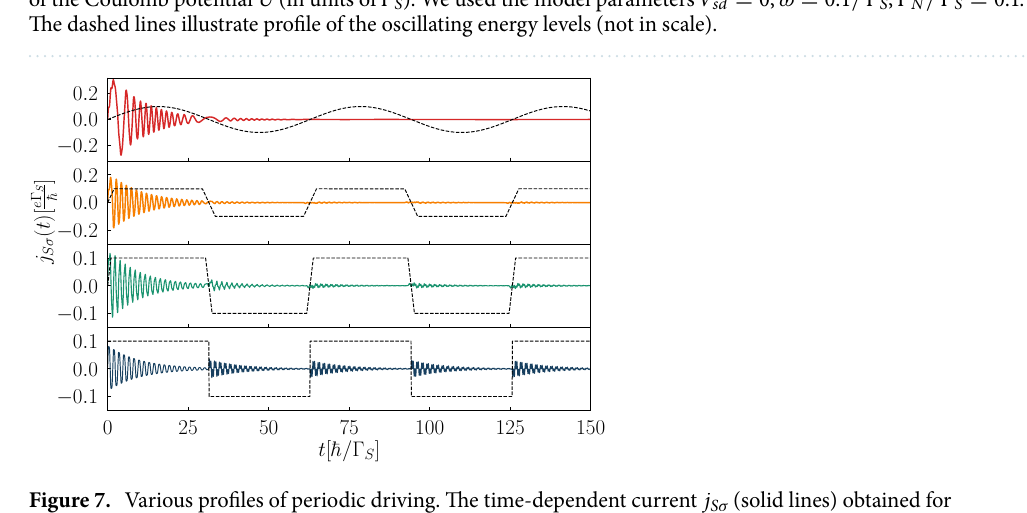
4 and several = 3 , A /Ŵ 3 and several values S = = 0.1 /Ŵ 0.1 . 0 , ω S , Ŵ N /Ŵ S = = =